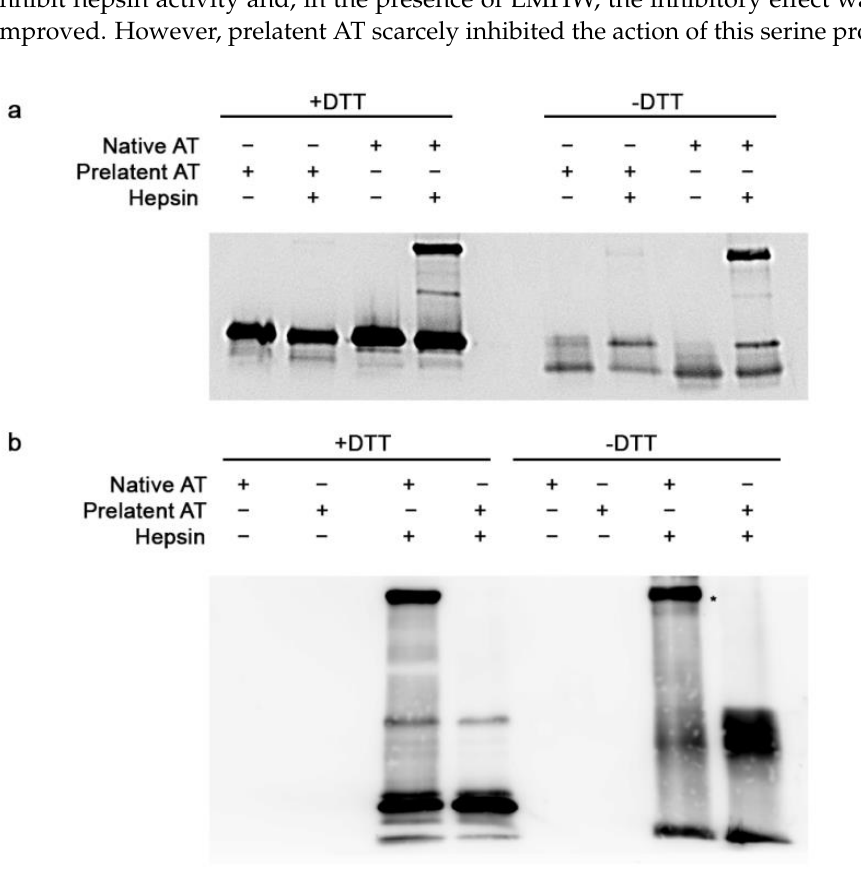
Figure 2. Electrophoretic evaluation of the interaction between antithrombin and hepsin. SDS- PAGE was run under reducing (+DTT) ( a ) and non-reducing ( − DTT) conditions ( b ), and Western blotting with immunodetection with anti-antithrombin antibody ( a ) or anti-hepsin antibody ( b ) was performed. Asterisk represents antithrombin–hepsin complex. AT: antithrombin. Table 2. Hepsin activity using its fluorogenic substrate after incubation with antithrombin.